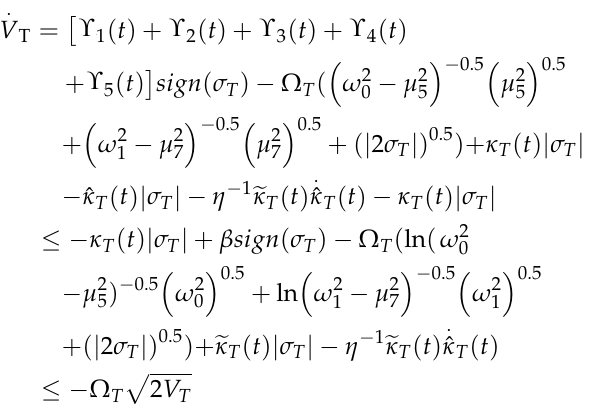
The second ‐ order backstepping ‐ based subsystems of the presented OFWT system are represented by Equation (25). Furthermore, two different control algorithms are pre ‐ sented for the stabilization of the OFWT model. The first one is called an adaptive integral sliding mode control and the second is the adaptive integral sliding mode control using BLF. The sliding manifold for each subsystem of Equation (25) is used for designing pro ‐ posed control laws, as follows: